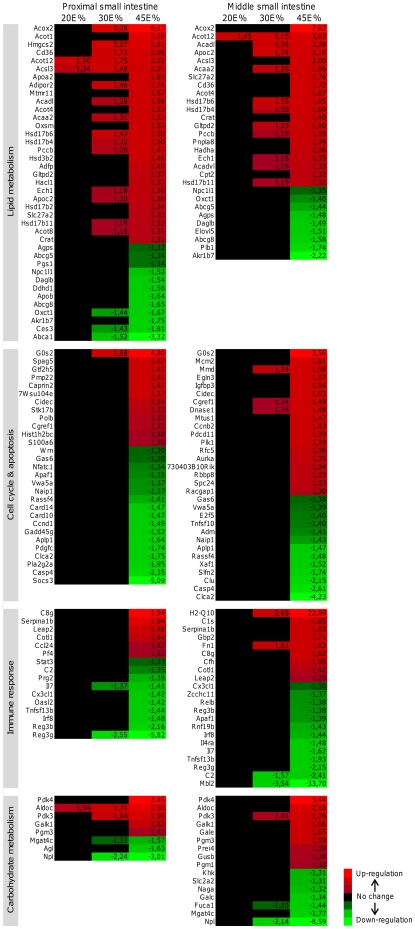
Heat map diagrams of fat-dose dependently changed genes, categorized according to their biological function.Fat-dose dependently changed genes were clustered in a heat map diagram for the proximal and middle part of the small intestine, based on their GO Biological Processes annotation. Genes involved in lipid metabolism, cell cycle/apoptosis, immune response and carbohydrate metabolism were highly overrepresented. The heat maps display fold changes of differential gene expression induced by the 20E%, 30E% and 45E% fat diets compared to the control 10E% fat diet (only genes with fold changes >1.3 or <−1.3 are shown). Red and green indicate (gradual) up- and down-regulation, respectively, whereas black means no change in gene expression.